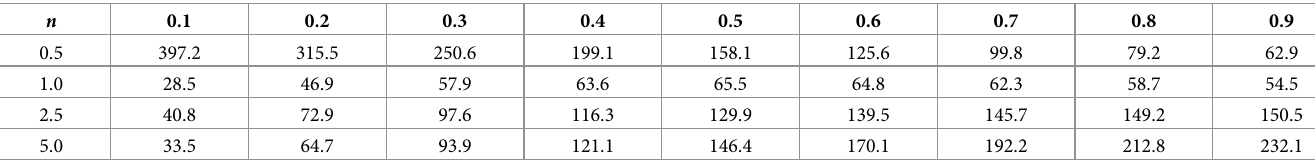
Table 2. The ratio of particle size in the